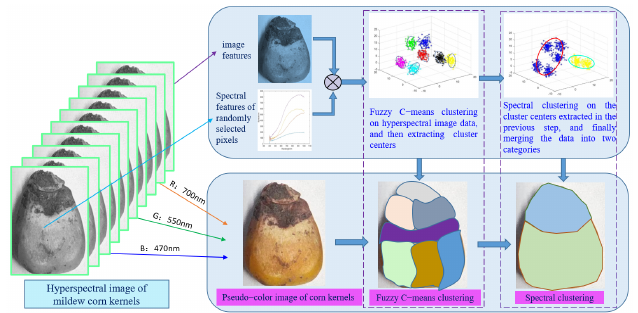
Figure 8. Detection algorithm for the hyperspectral image of corn kernel mildew.